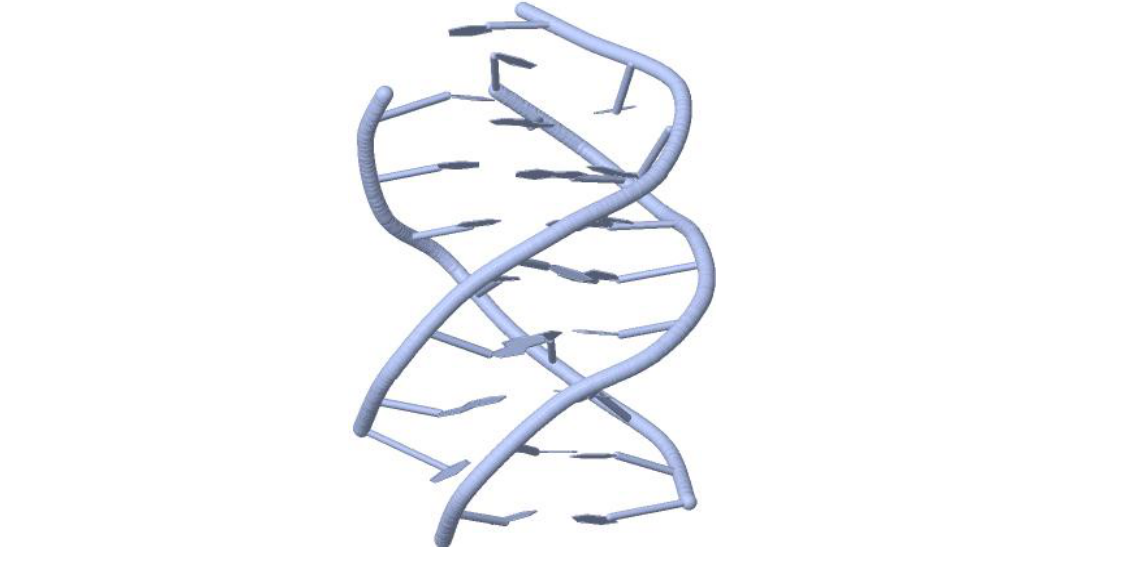
FIGURE 1. Cartoon of 3D structure of a purine-purine-pyrimidine DNA triplex containing G-GC and T-AT triples. This picture is a snapshot of the structure with the identifier 134D obtained from the Protein Data Bank. The structure was resolved using a combined NMR and molecular dynamics approach by Radhakrishnan and